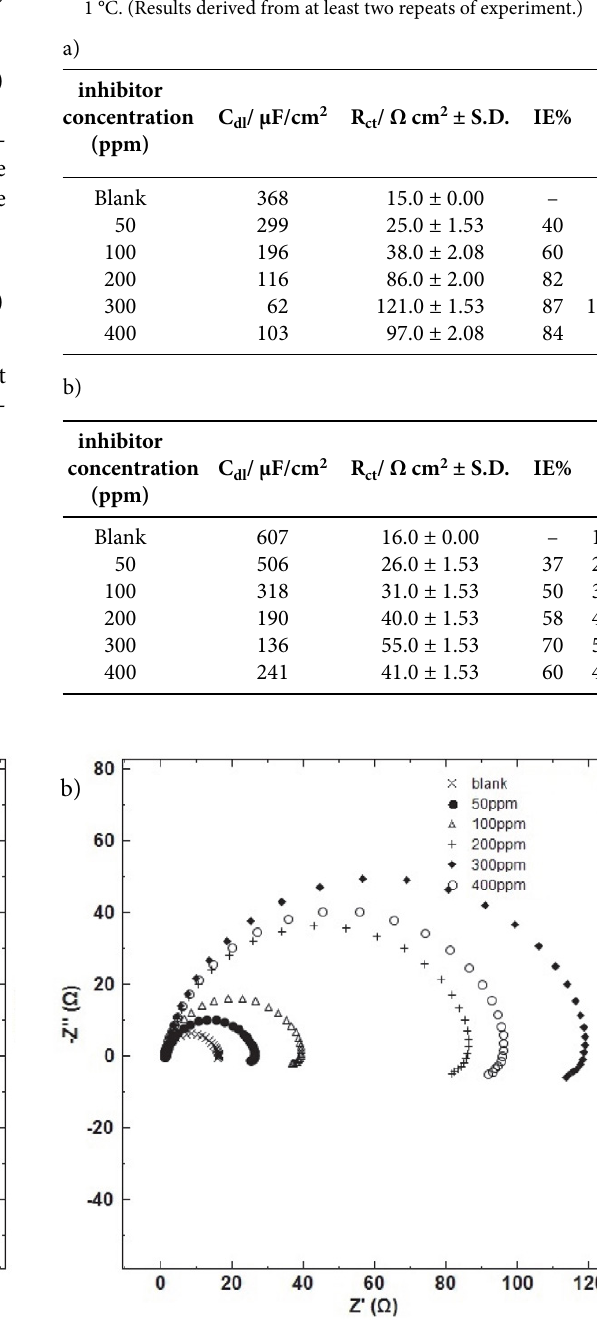
Figure 2. Nyquist curves for mild steel in a) 1 M hydrochloric acid solution and b) 0.5 M sulfuric acid solution in absence and presence of different concentrations of inhibitor at 25 ± 1 °C. (The experiments were repeated at least two times)